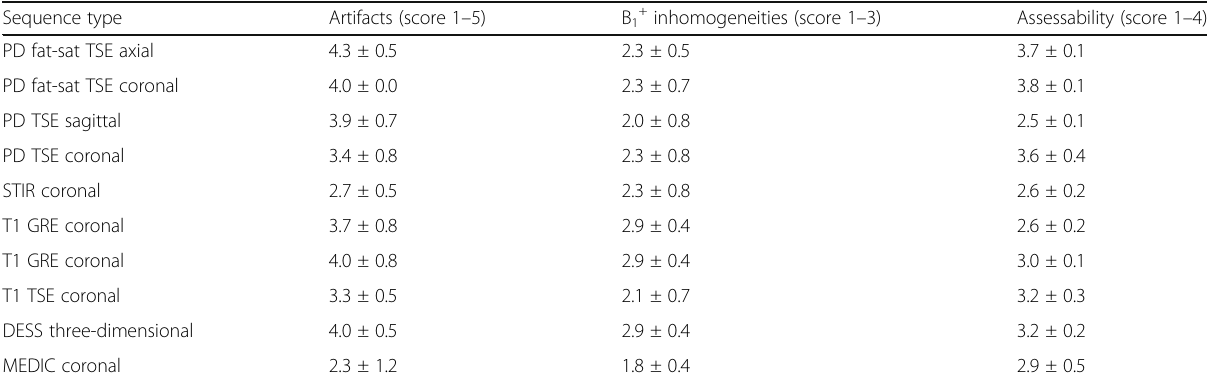
Table 2 Image quality evaluation Sequence type